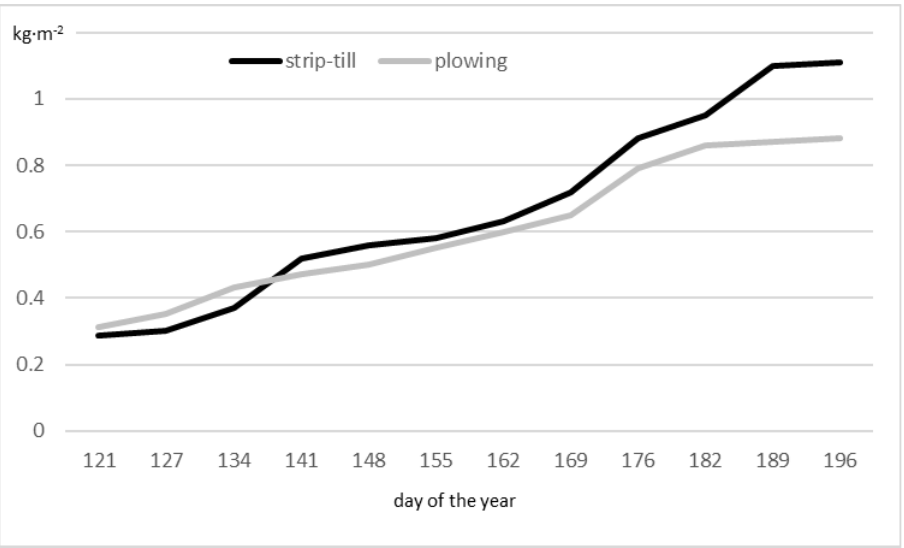
Figure 1. Dynamics of winter barley dry matter increase depending on cultivation technology (30 April 2016 – 14 July 2016).